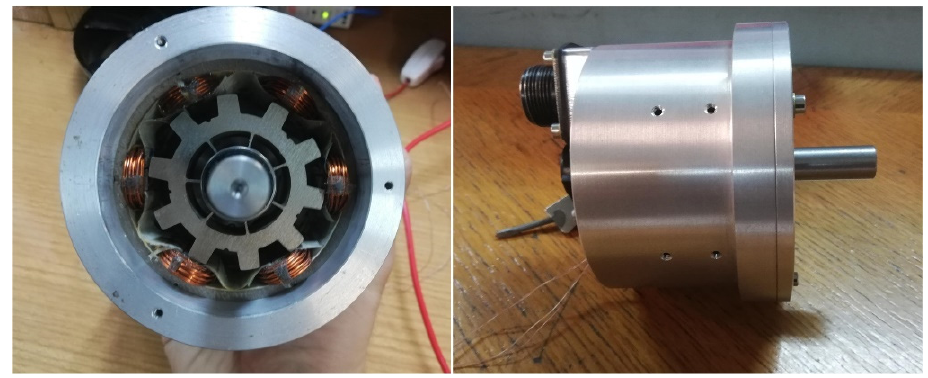
Figure 27. Flux linkage curves for initial and modified rotor designs.